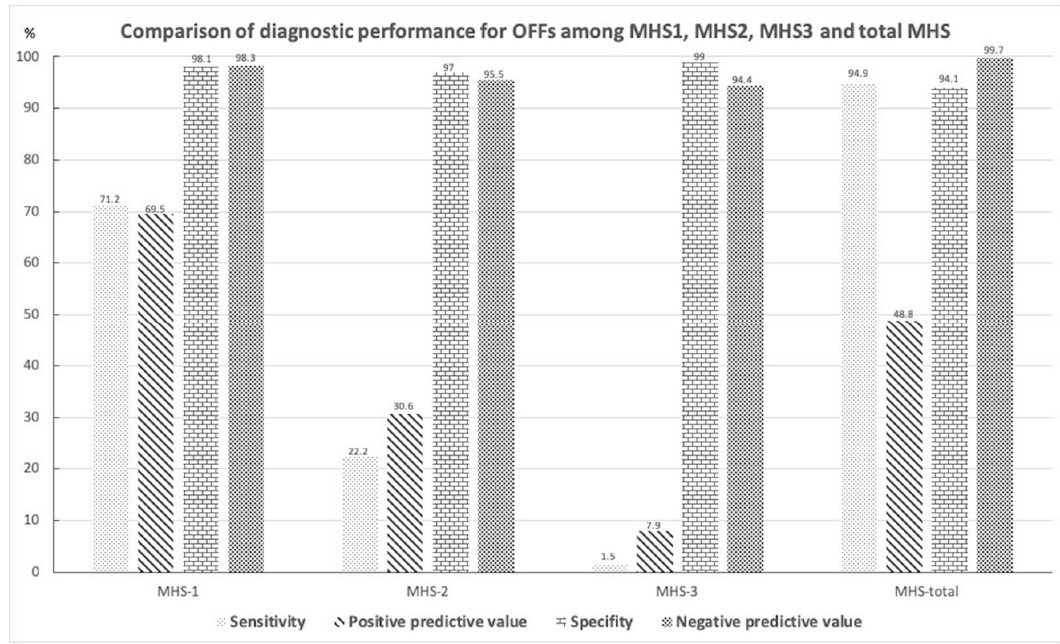
Figure 4. Diagnostic performance of the total and the three subtypes of MHS.